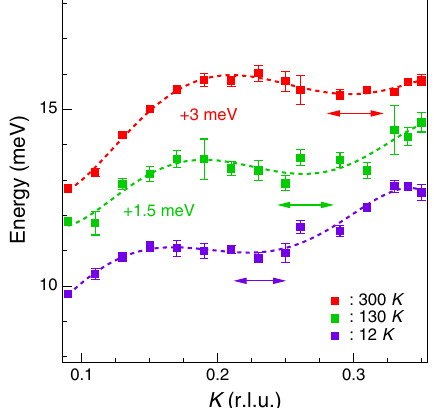
FIG. 5. Temperature-dependent phonon incommensurability in La 1 Ba 0 CuO 4 . Extracted phonon dispersions of M 2 at 12, . 875 . 125 130, and 300 K along ( 0 K 14.5) are shown as purple, green, and red squares. Dashed lines are guides to the eye, and arrows indicate the Q associated with the CDW-related phonon soften- ing. Dispersions at 130 and 300 K are offset by 1.5 and 3 meV, respectively, for